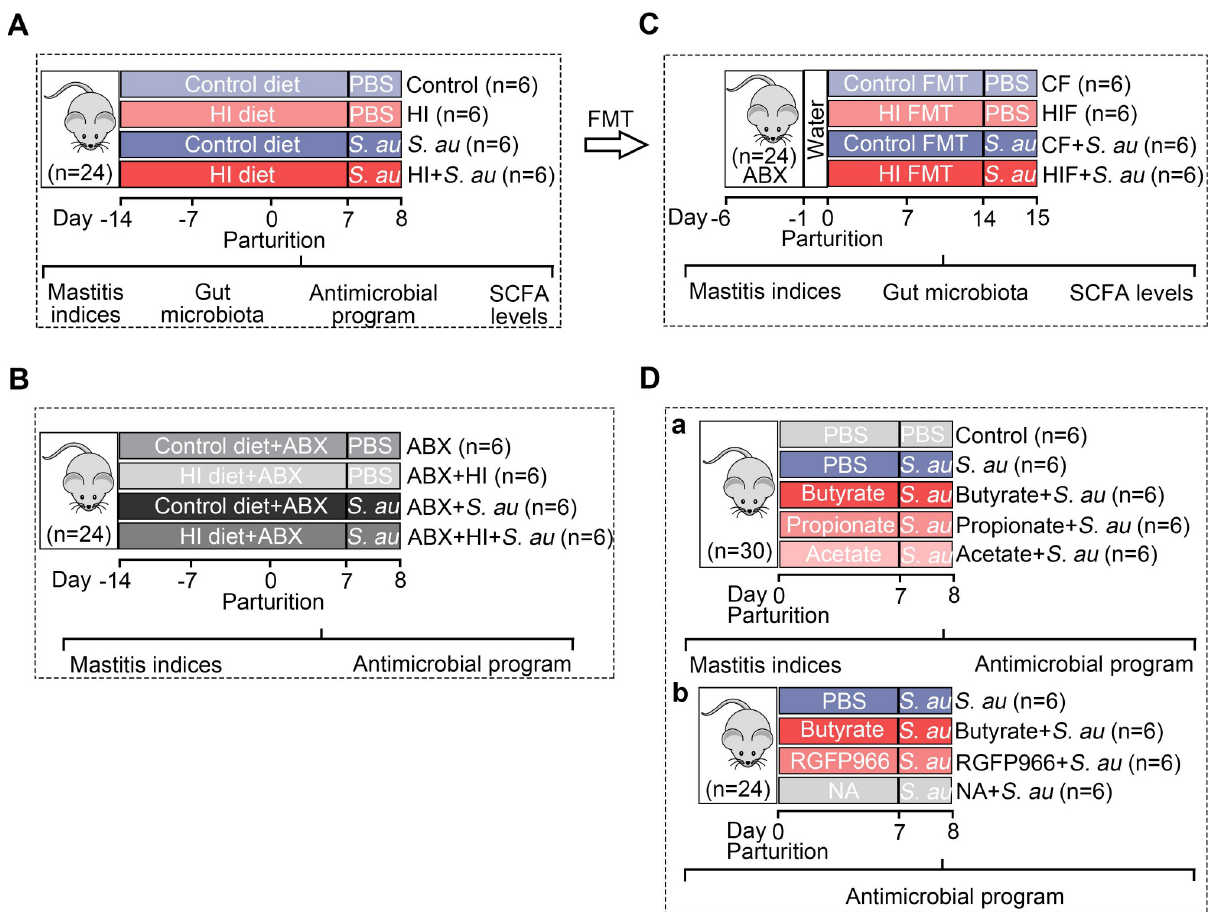
Fig 1. Experimental overview. A. The effects of a high-fiber diet on S . au -induced mastitis in mice were investigated. Mice were separated into four groups, including control, high-inulin (HI), S . au and HI + S . au groups (n = 6 per group), and fed with control or HI diet for three weeks followed by S . au -induced mastitis. B . The depletion of the gut microbiota by antibiotic cocktail (ABX) was performed to investigate the role of gut microbiota in HI diet-mediated protective effects on S . au -induced mastitis (n = 6 per group). C . Fecal microbiota transplantation (FMT) from control- (CF) or HI diet- (HIF) treated mice was used to confirm the role of gut microbiota (n = 6 per group). D . The effects of butyrate, propionate and acetate on S . au -induced mastitis were investigated ( a ) and HDAC inhibitors, including RGFP966 and NA, were used to investigate the underlying mechanism ( b ) (n = 6 per